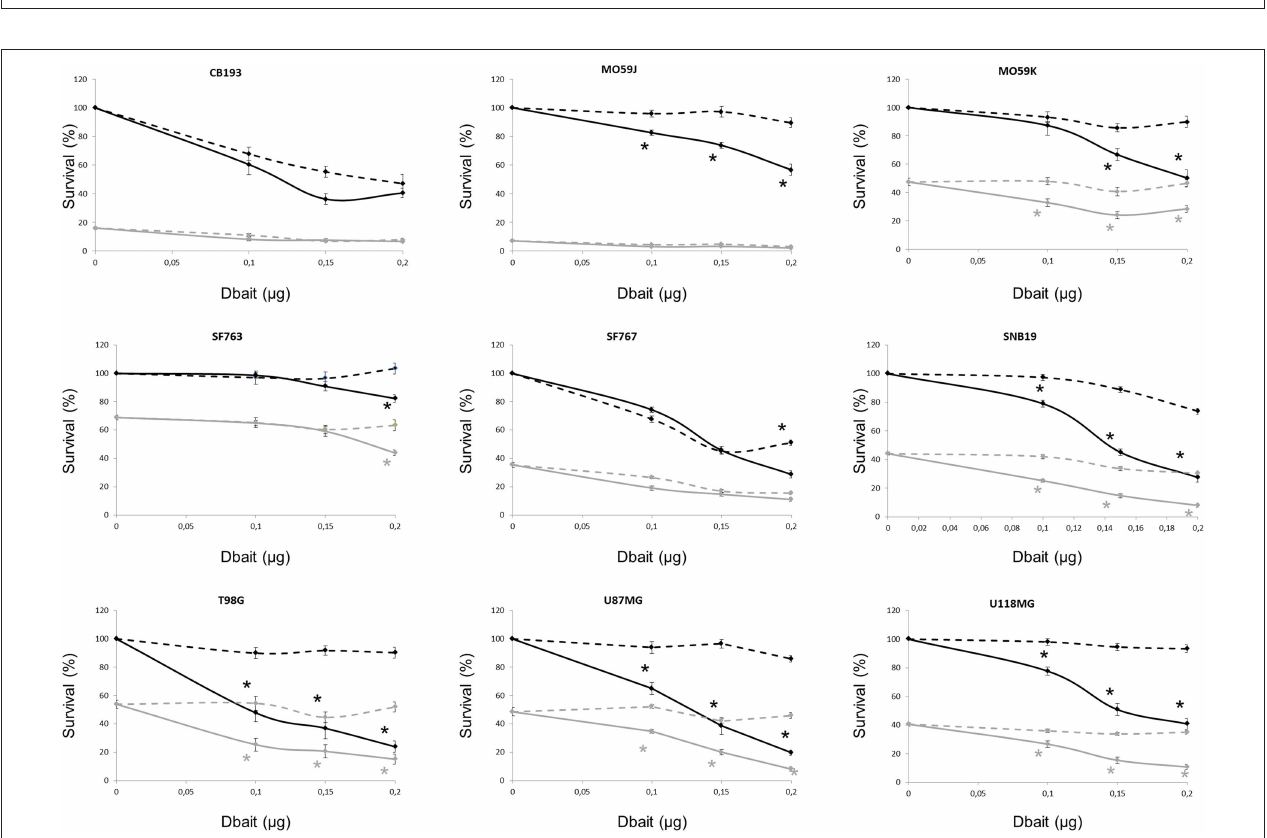
FIGURE 3 | Dbait impact on cell survival. Cell survival assay of high grade glioma cell lines were treated with Dbait (solid line) or control (dotted line). Cells were irradiated at 2.5Gy (gray line) or not (black line) 5h after Dbait treatment. Data are represented as mean values ± standard error. Mann-Whitney test was performed (* p <